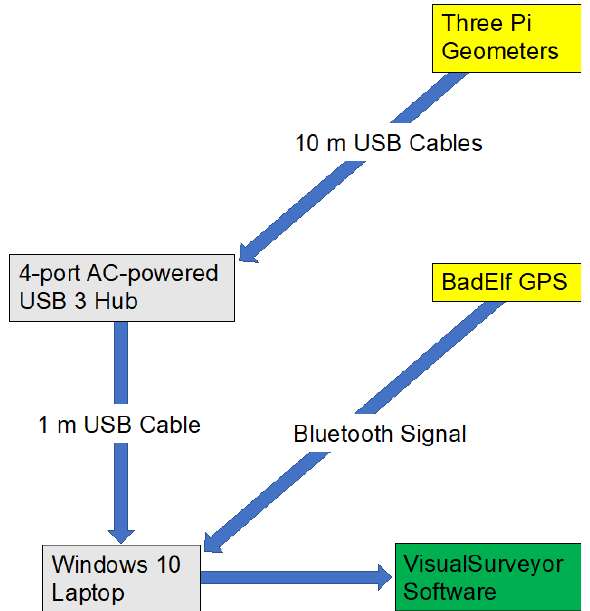
Figure 6. Signal connections for the multiple Geometers used to input declination measures from three observer positions to the VisualSurveyor software aboard a Fisheries and Oceans Canada chartered Twin Otter.